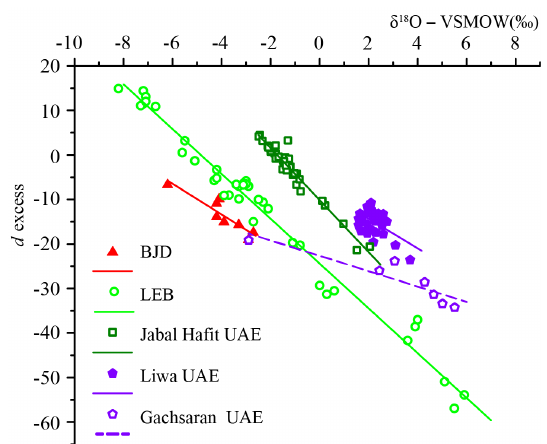
Figure 7. Comparison of d -excess and δ 18 O values of groundwater samples from the BJD (red triangle); Lake Eyre Basin, Australia (green circle; Tweed et al., 2011); Jabal Hafit, UAE (dark green square; Murad and Mirghni, 2012); and the two aquifers, Liwa and Gachsaran of Rub Al Khali, UAE (purple; Wood, 2011). The trend lines are established and plotted in same color following the data.